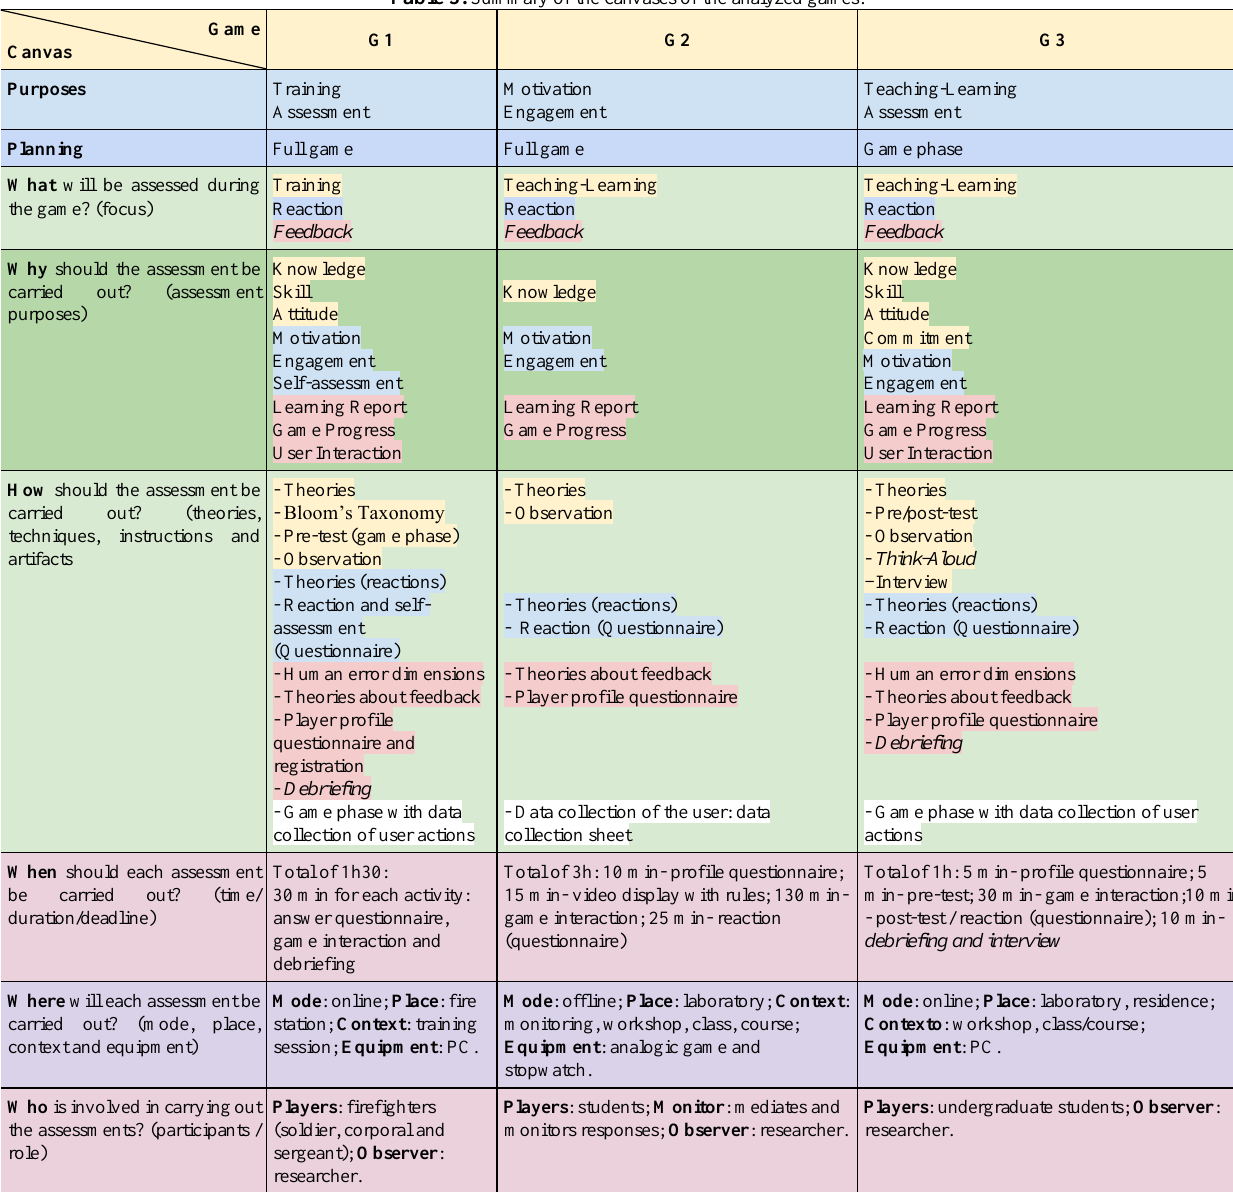
Table 3. Summary of the canvases of the analyzed